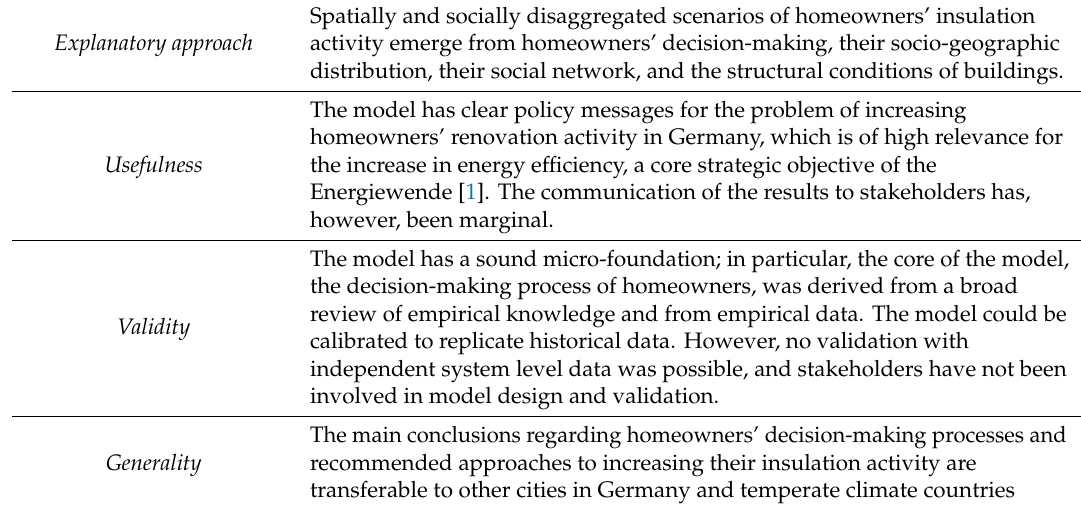
Table 1. Overall summary and assessment of case 1 (insulation) with regard to explanatory approach, usefulness, validity and